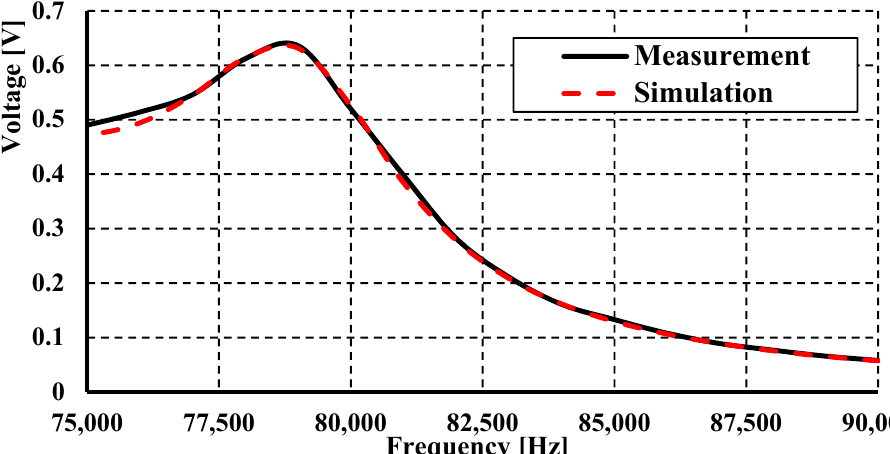
Figure 11. EM radiation verification—induced voltage level on measuring coil at 20 mm distance (Shielded WPT system).